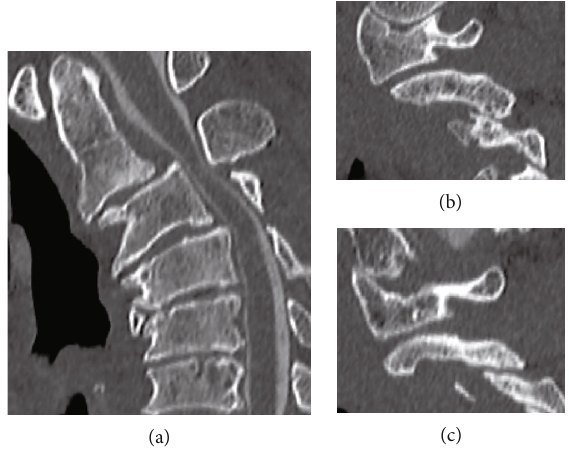
Figure 2: Preoperative CT myelography images. (a) Sagittal view. (b) Right view and (c) Left view of the C2-3 facet joint. CT images show that the bilateral pars interarticularis were not fractured.